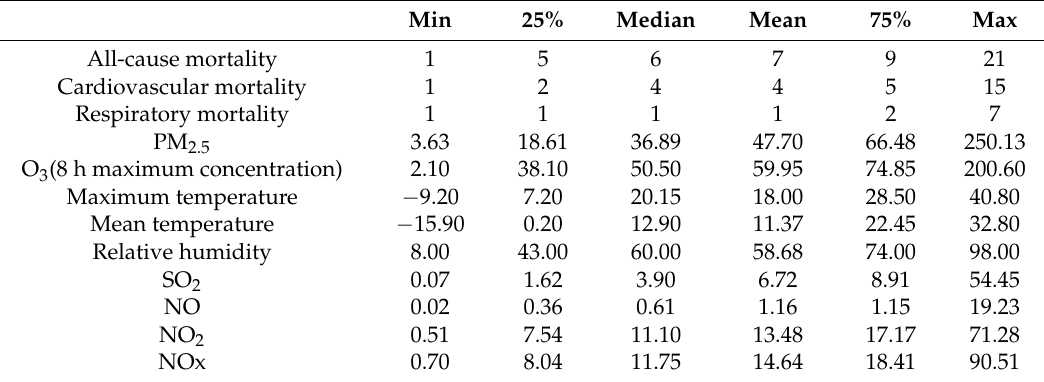
Table 1. Summary of health outcomes, pollutants, and meteorological